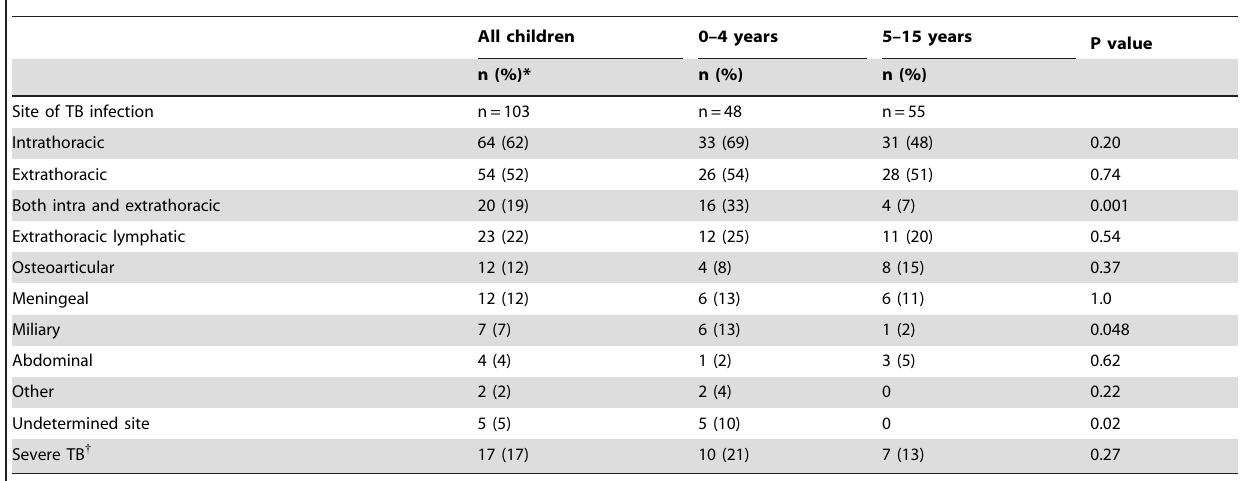
Table 2. Site of TB Disease According to Age.